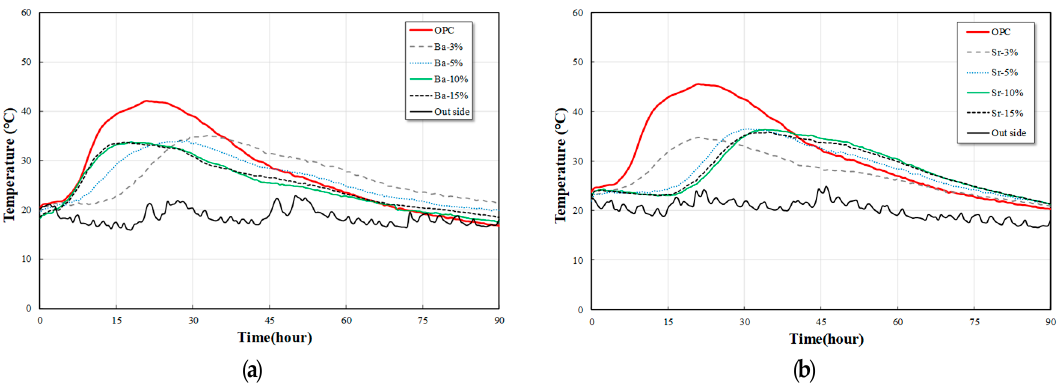
Figure 10. Effects of addition mix ratio of PCM on semi-adiabatic temperature rise—( a ) cement mortar with PCM-Ba; ( b ) cement mortar with PCM-Sr.